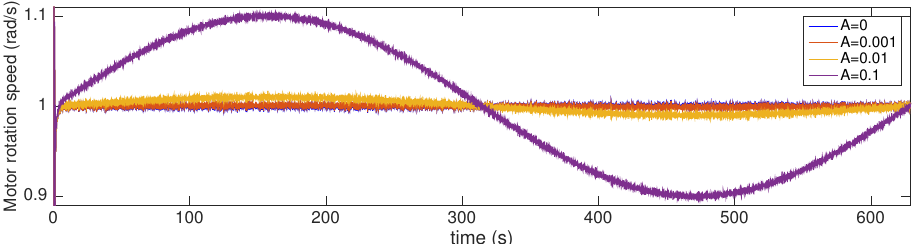
Figure 14. Examples of sensor outputs y (cid:48) ( k ) in simulations with different amplitudes A